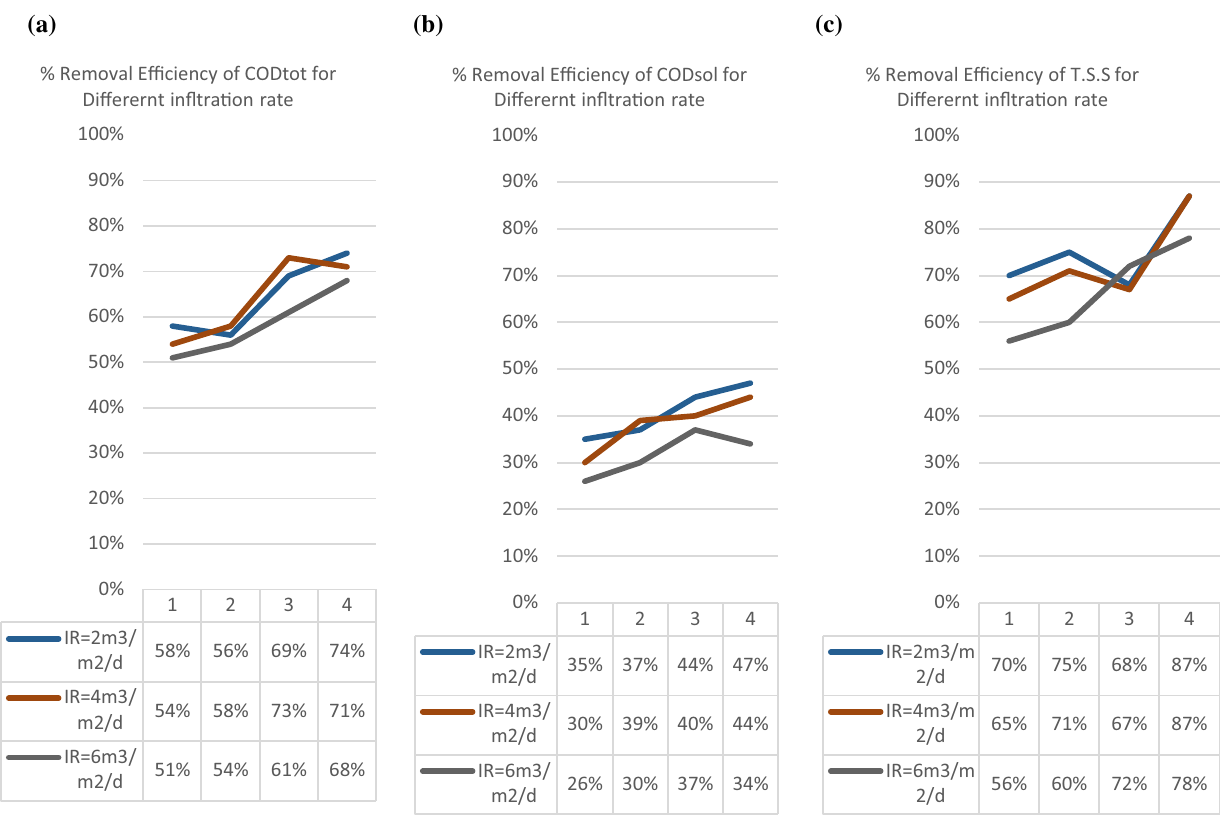
tot for different I.R, b) %R.E. of COD sol for different I.R, c) %R.E. of TSS for different